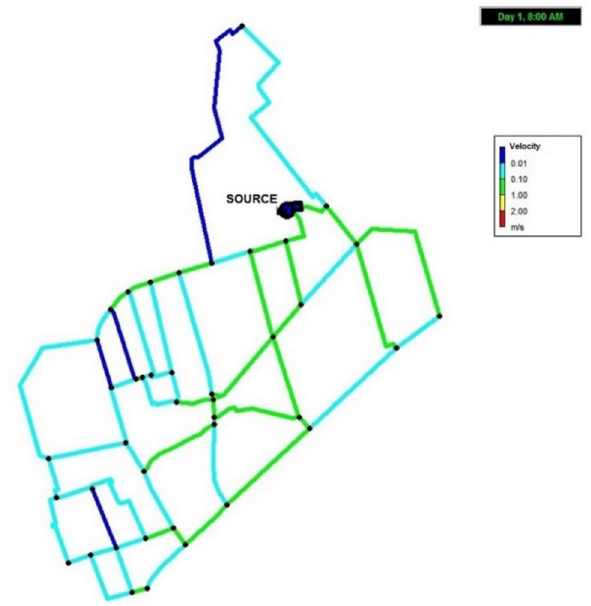
Fig. 11 Water velocity in the water supply network at the time of the highest consumption